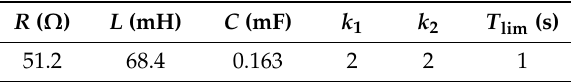
Table 2. Parameters used in the